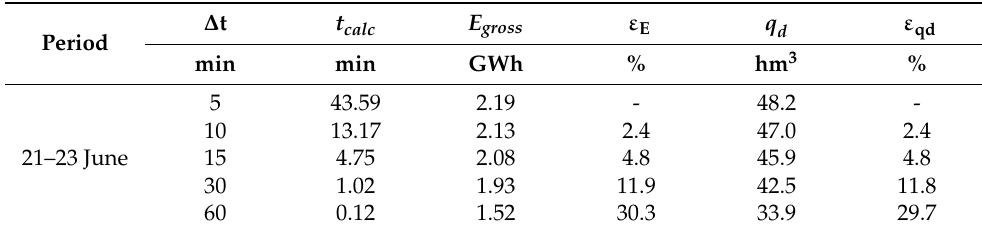
Table 1. Simulation of the electric gross energy ( E gross ) and freshwater production ( q d ) as a function of the time step ( ∆ t ) during three days in summer: 21–23 June 21. ε E and ε qd are the relative errors of E gross and q d , respectively.